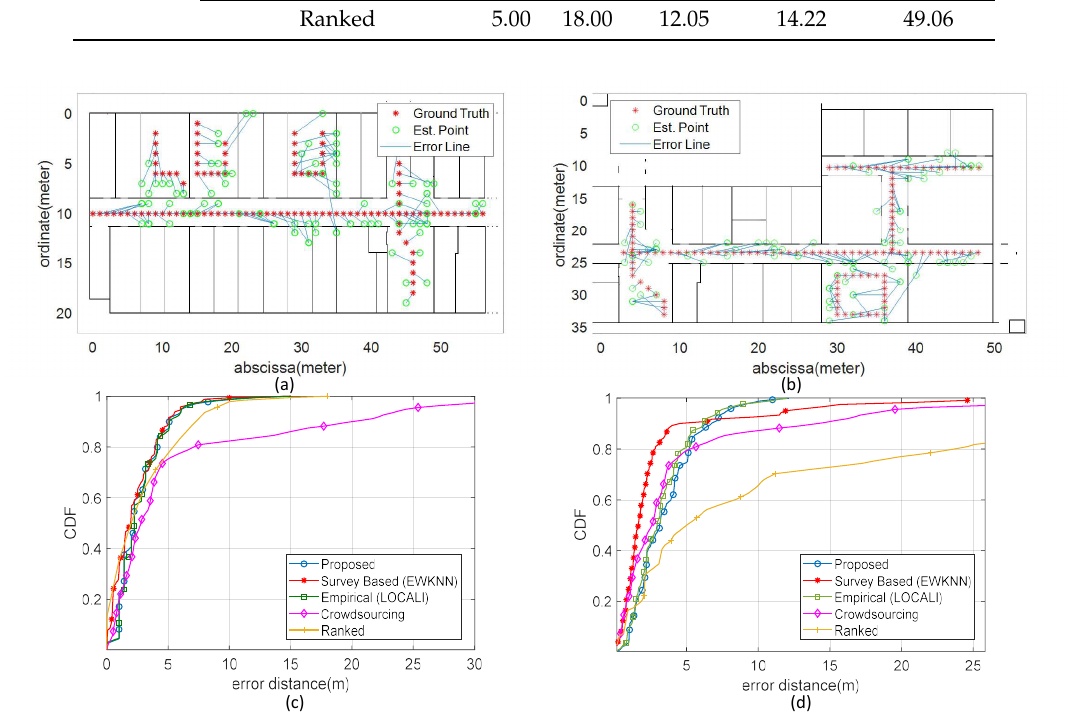
Figure 14. Comparison of ground truth, estimated position, and error distance for both sites. ( a ) The ICE department. ( b ) The CS department. And Cumulative distribution function of the positioning errors (CDF) for both sites. ( c ) The ICE department. ( d ) The CS